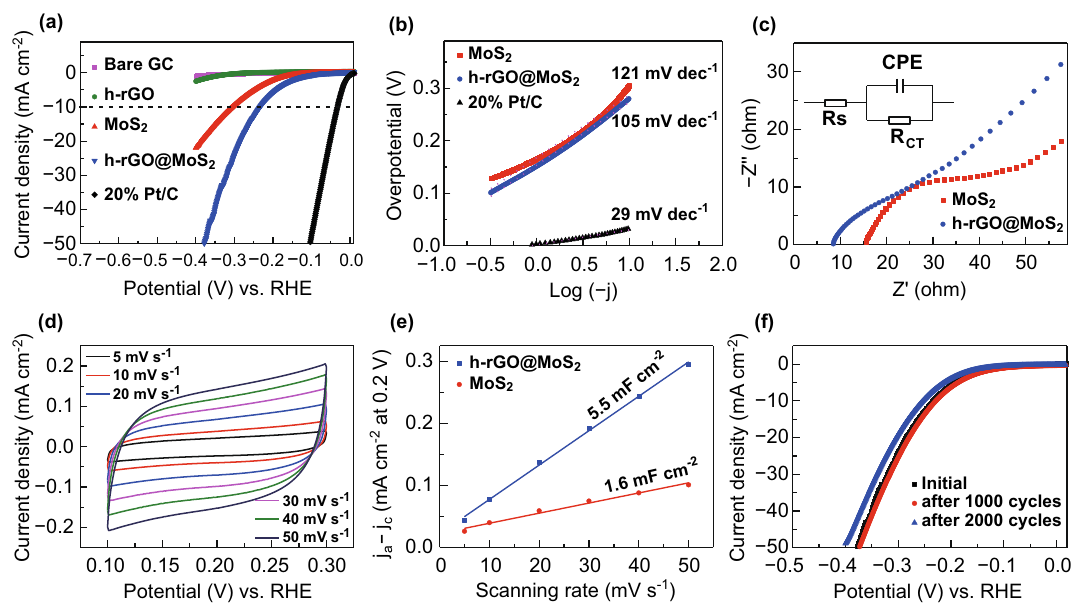
Fig. 3 a Polarization curves of bare GC, h-rGO, pristine MoS 2 , h-rGO@MoS 2 , and commercial 20% Pt/C in 0.5 M H 2 SO 4 electrolyte at 5 mV s - 1 , and b the corresponding Tafel plots of electrocatalysts in a . c EIS plots of pristine MoS 2 and h-rGO@MoS 2 from 10 - 2 to 10 5 Hz. d The electrochemical double-layer capacitances of h-rGO@MoS 2 ranging from 0.1 to 0.3 V at various scan rates (5, 10, 20, 30, 40, and 50 mV s - 1 ) in 0.5 M H 2 SO 4 . e The capacitive current at 0.20 V as a function of scan rate for pristine MoS 2 and h-rGO@MoS 2 in 0.5 M H 2 SO 4 electrolyte. f Polarization curves of the h-rGO@MoS 2 electrocatalysts initially and after 1000 and 2000 cycles in 0.5 M H 2 SO 4